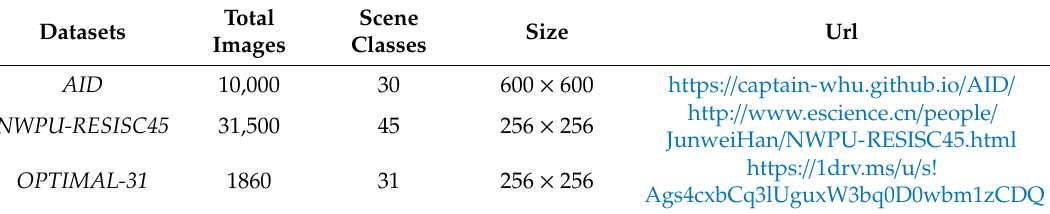
Figure 1. Some examples of remote sensing scene images. They are beach, parks, port, and school. Table 1. Information about